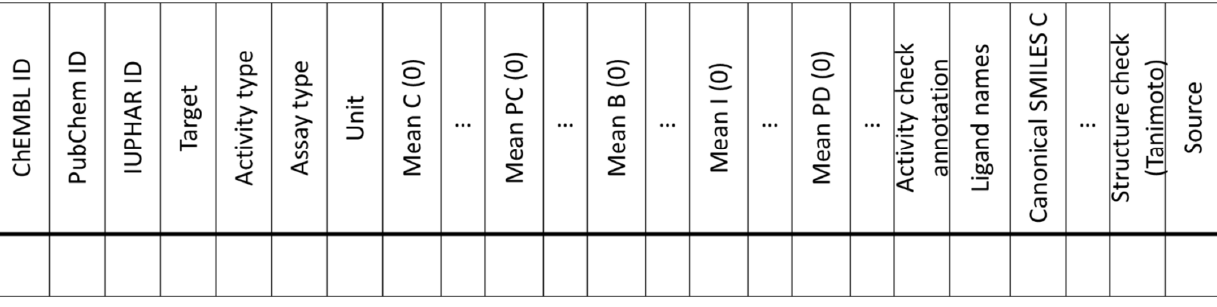
Figure 3. Structure of the consensus dataset.